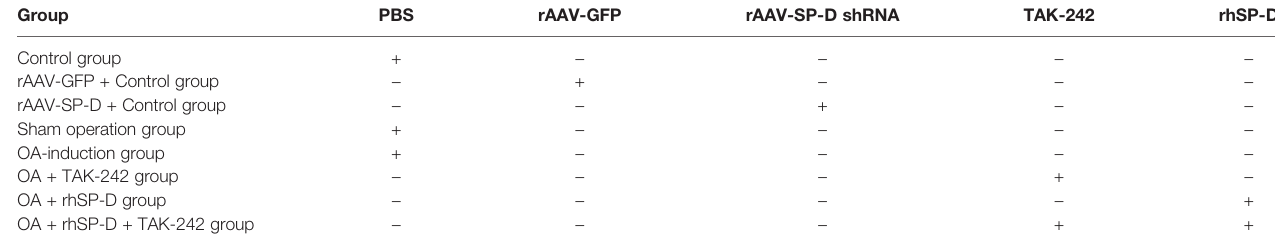
TABLE 1 | The treatments in each